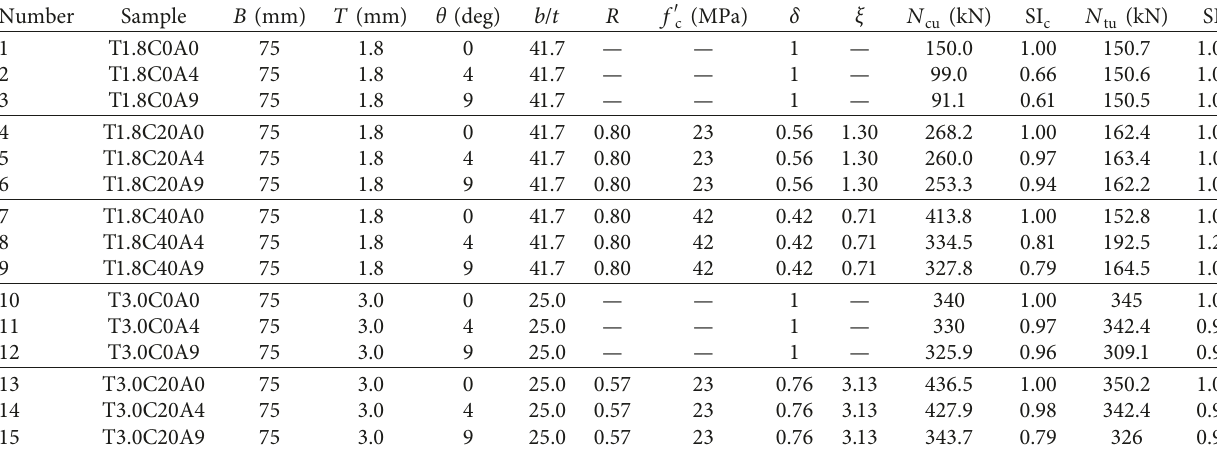
Figure 1: Example of application of inclined column. Table 1: